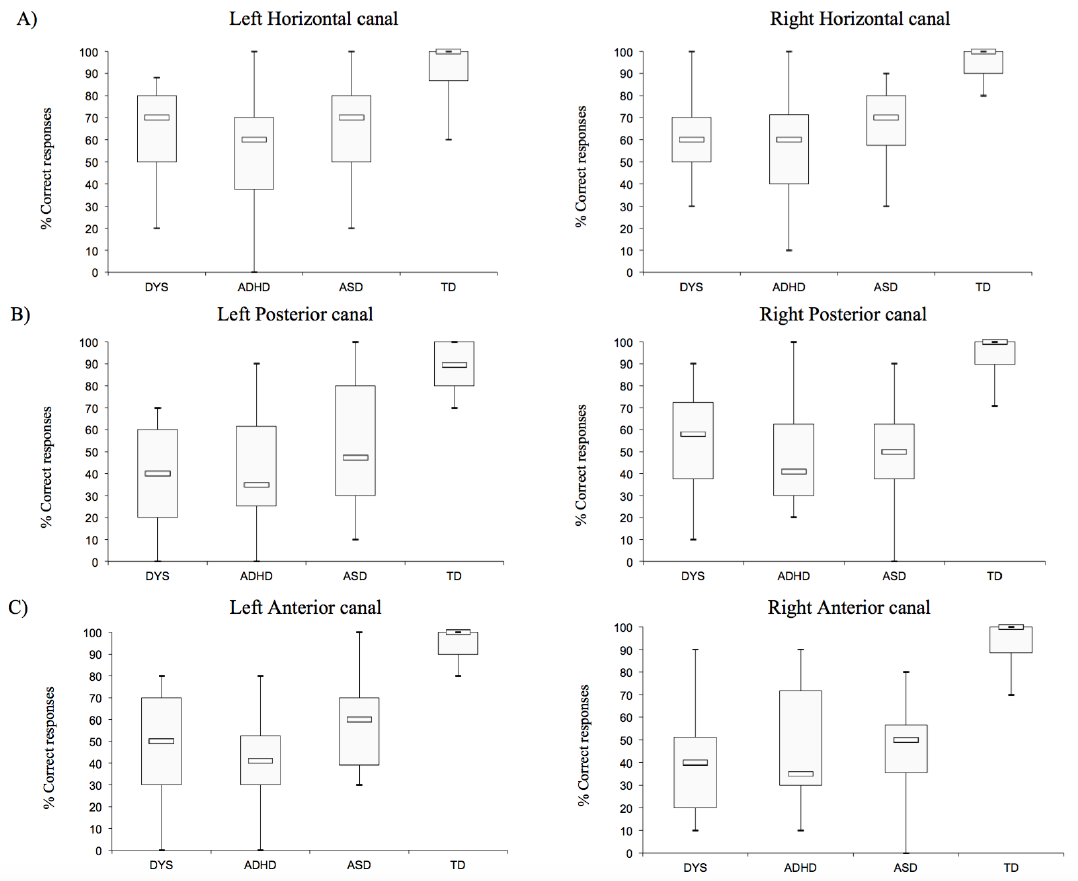
Figure 2. Boxplot with median and inter-quartile range of corrected answer of the Landolt C optotypes in the left- and rightward direction for each vestibular canal ( A ): horizontal, ( B ): posterior, and ( C ): anterior for each child tested. DYS, children with dyslexia; ADHD, children with attention deficit hyperactivity disorder; ASD, children with autism spectrum disorders; TD, children with typical